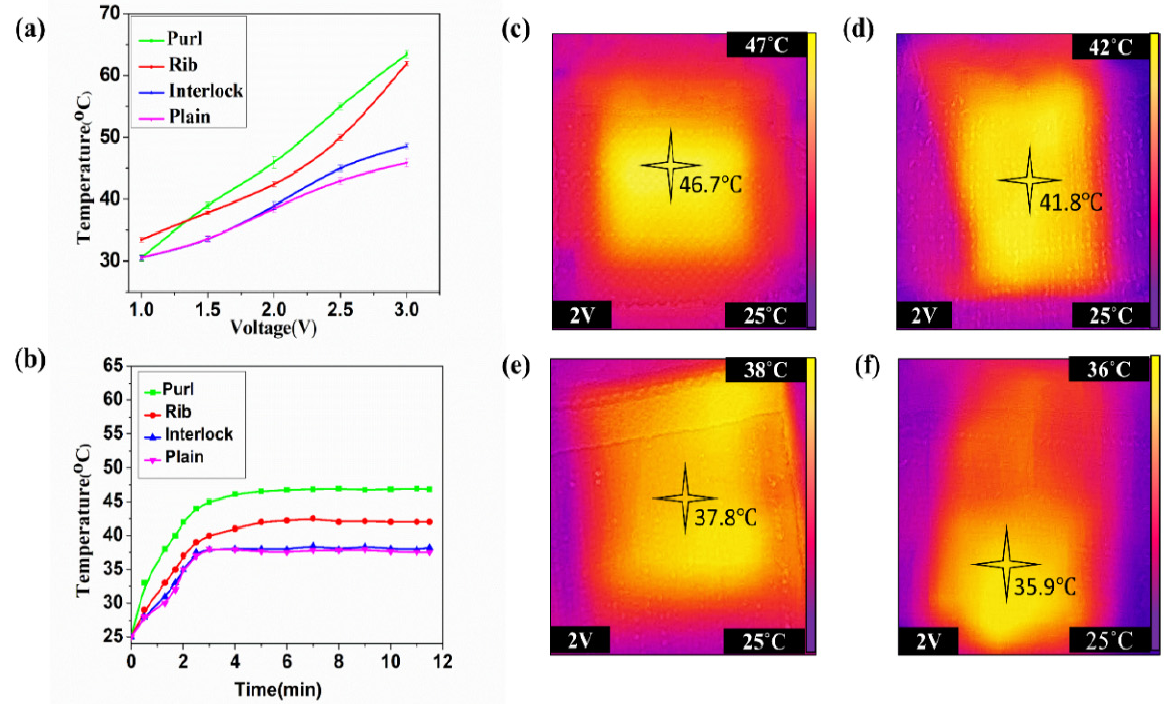
Figure 6. ( a ) Temperature change of different structures under different voltages, ( b ) at a constant voltage of 2V, thermal image of ( c ) purl, ( d ) rib, ( e ) interlock, and ( f ) plain.